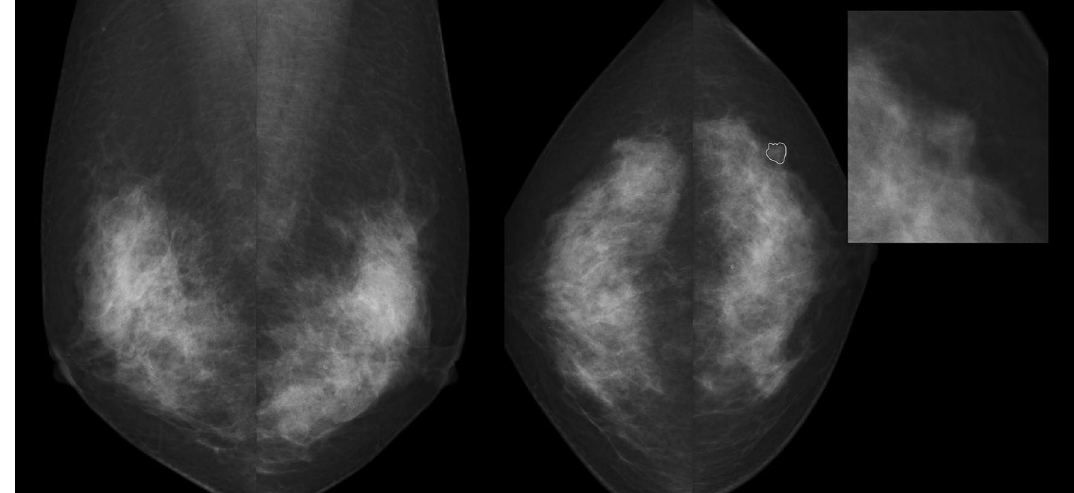
Fig. 4 DM examination of a woman 50 years old without any diagnosed pathology. AI‑DM yielded a false positive assessment since it assigned a high score to the case (92.6, scale 1–100) based on the delineated suspicious density, both radiologists assigned BI‑RADS 3 to the case while AI‑ABUS assigned a lower score (76.1, scale 1–100) showing the potential of AI‑ABUS to also reduce the false positives of